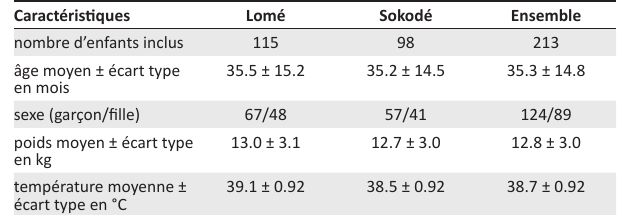
TABLEAU 1: Caractéristiques générales des enfants inclus dans l’étude.